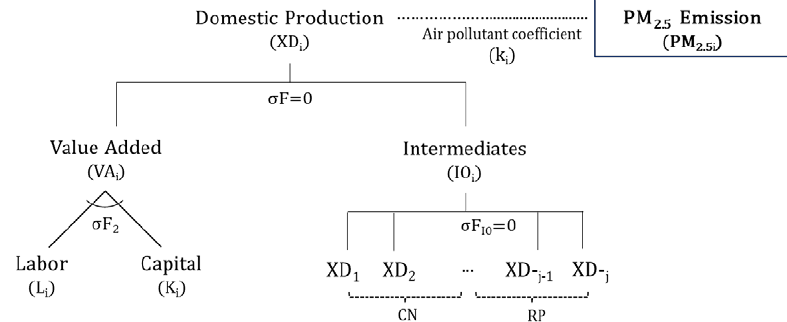
Figure 5. Nesting structure of the production sector in a single-country regional static computable general equilibrium (CGE) model.